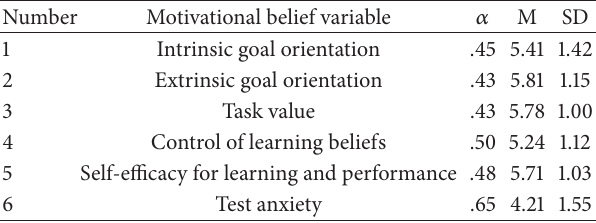
Table 1: Coefficient alphas and descriptive statistics for each motivational belief